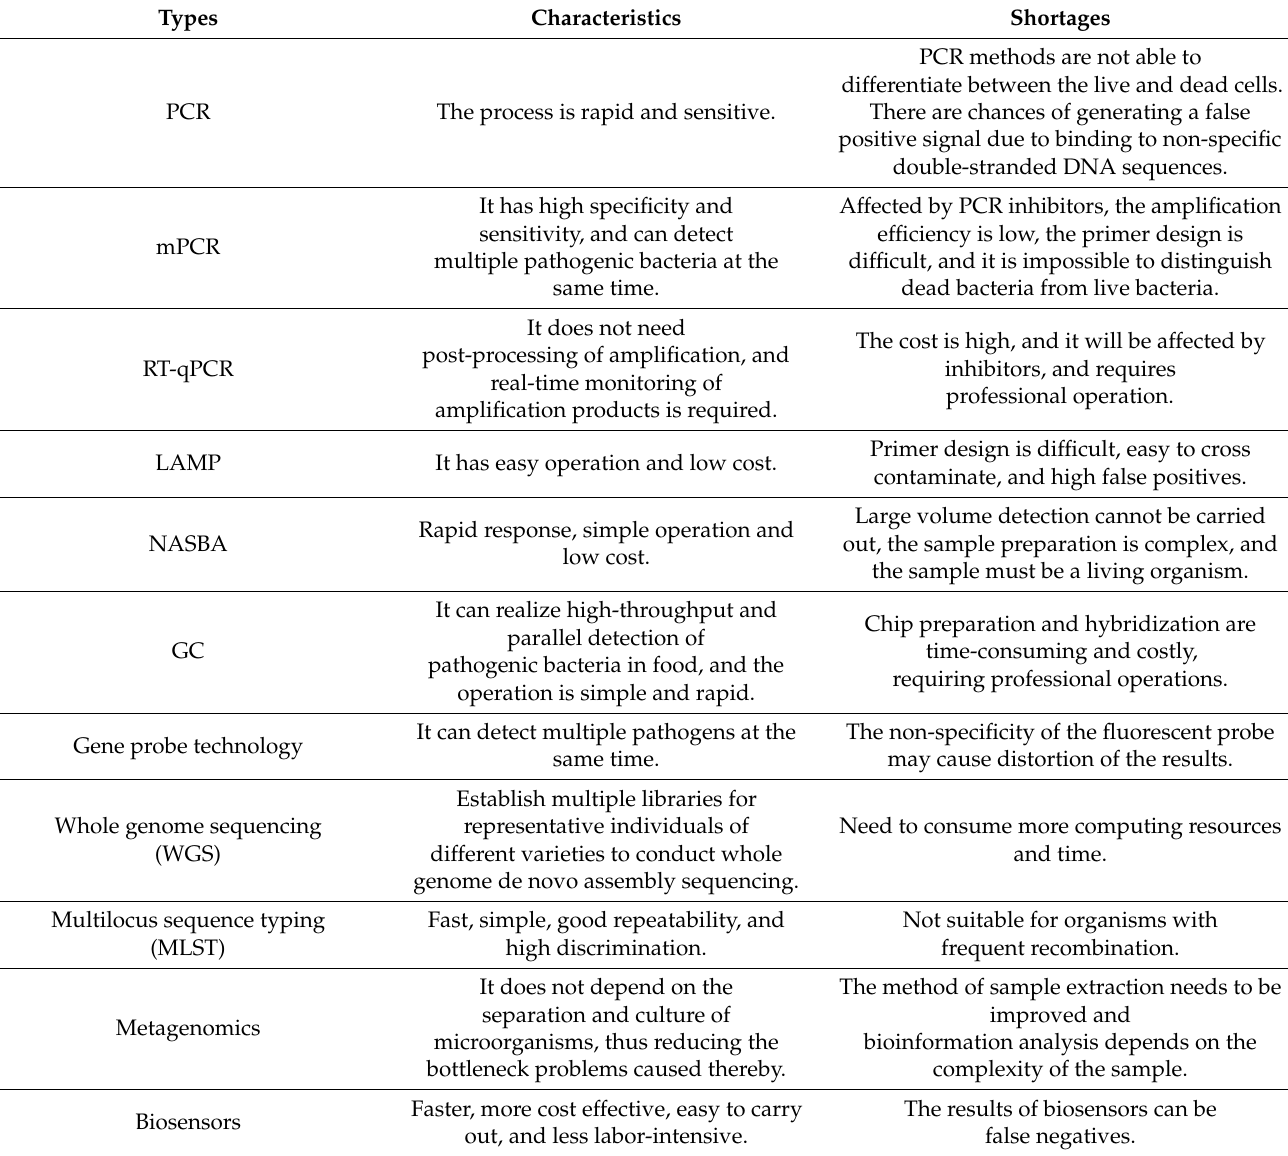
Table 3. Characteristics and shortages of various detection